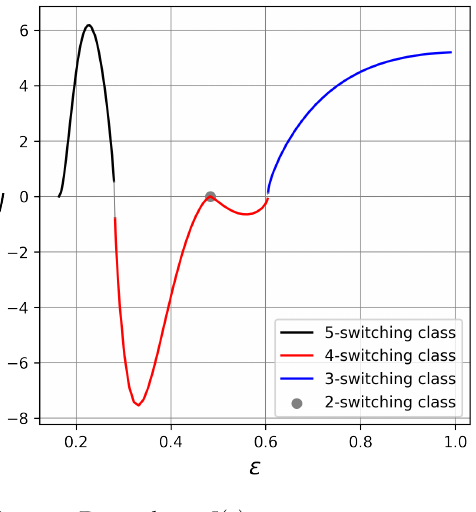
Figure 7. Dependence J ( ε )